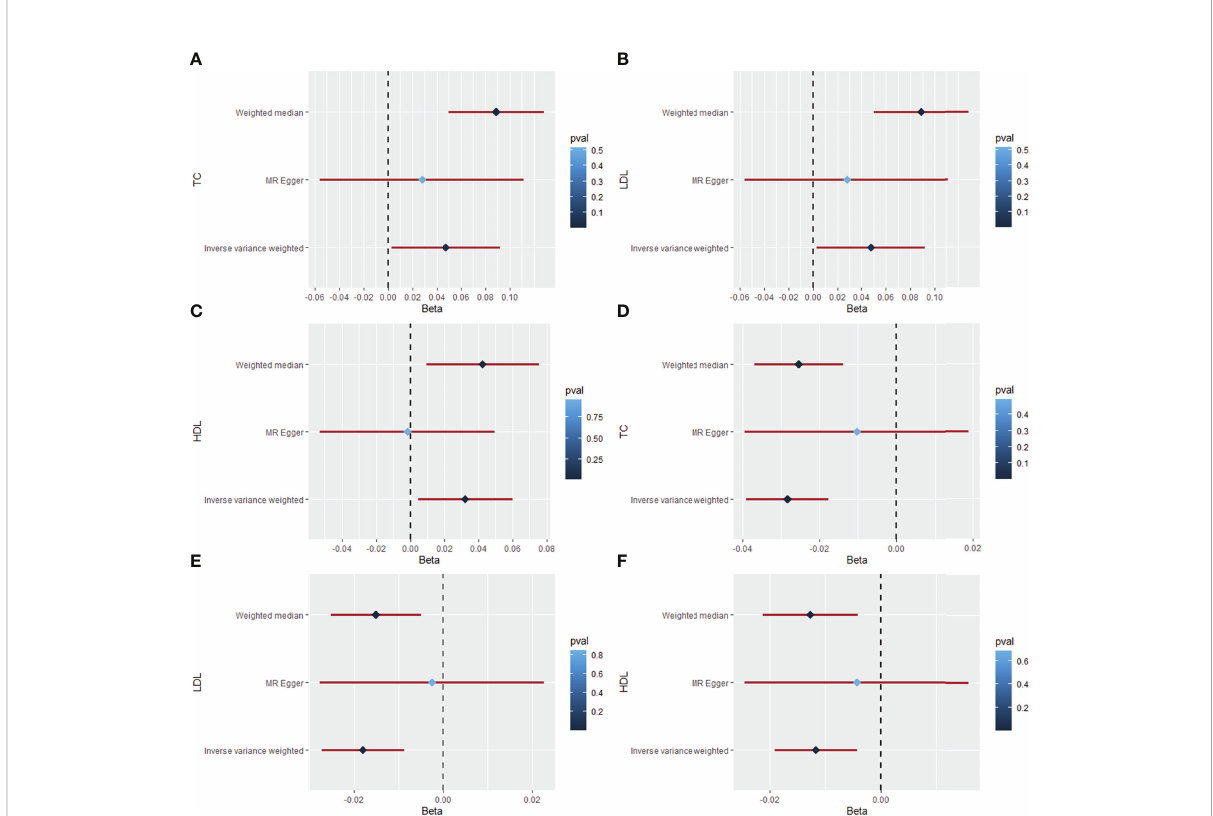
FIGURE 2 The forest plot for causal effects of rheumatic diseases on dyslipidemia. (A) Forest plot of the casual effect of AS on TC. (B) Forest plot of the casual effect of AS on LDL. (C) Forest plot of the casual effect of AS on HDL. (D) Forest plot of the casual effect of SLE on TC. (E) Forest plot of the casual effect of SLE on LDL. (F) Forest plot of the casual effect of SLE on HDL. (AS, ankylosing spondylitis; RA, rheumatoid arthritis; SLE, systemic lupus erythematosus; TC, total cholesterol; LDL, low-density lipoprotein; HDL, high-density lipoprotein; beta ( b ), a ratio of changes in standard deviations).